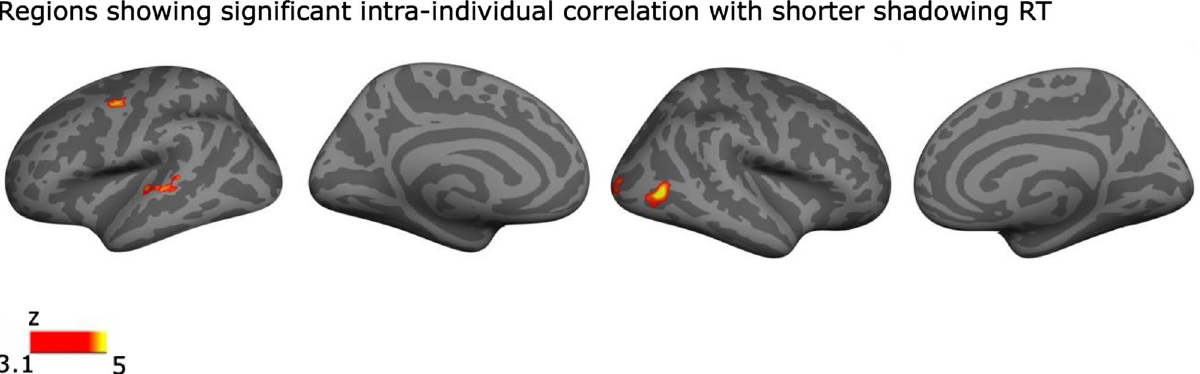
Figure 7. Significant clusters where shorter response times (RTs) were associated with stronger activations in the shadowing task. Significant clusters (initial cluster threshold z = 3.1; permutated cluster significance p < 0.05, FWER corrected) for the correlation effect (within subjects) between RT in the shadowing task and neural activations. From left to right: lateral and medial views of the inflated left hemisphere and lateral and medial views of the right hemisphere (lighter gray denotes gyri and darker gray